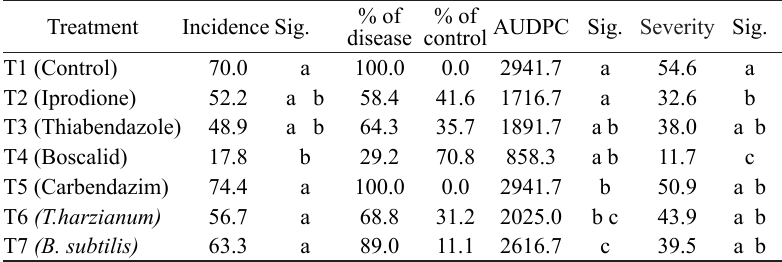
Table 4. Percentage of disease incidence, Area Under Disease Progress Curve (AUDPC), severity and control treatment percentage, on field without broccoli. (Alfa=0.05) Treatment Incidence